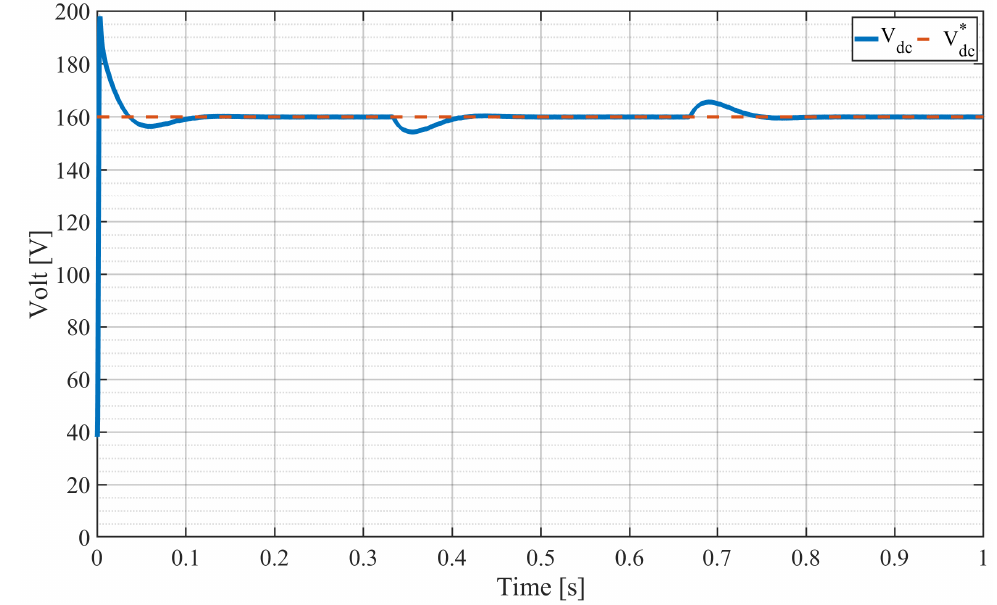
Figure 11. DC-link voltage measurement during one second